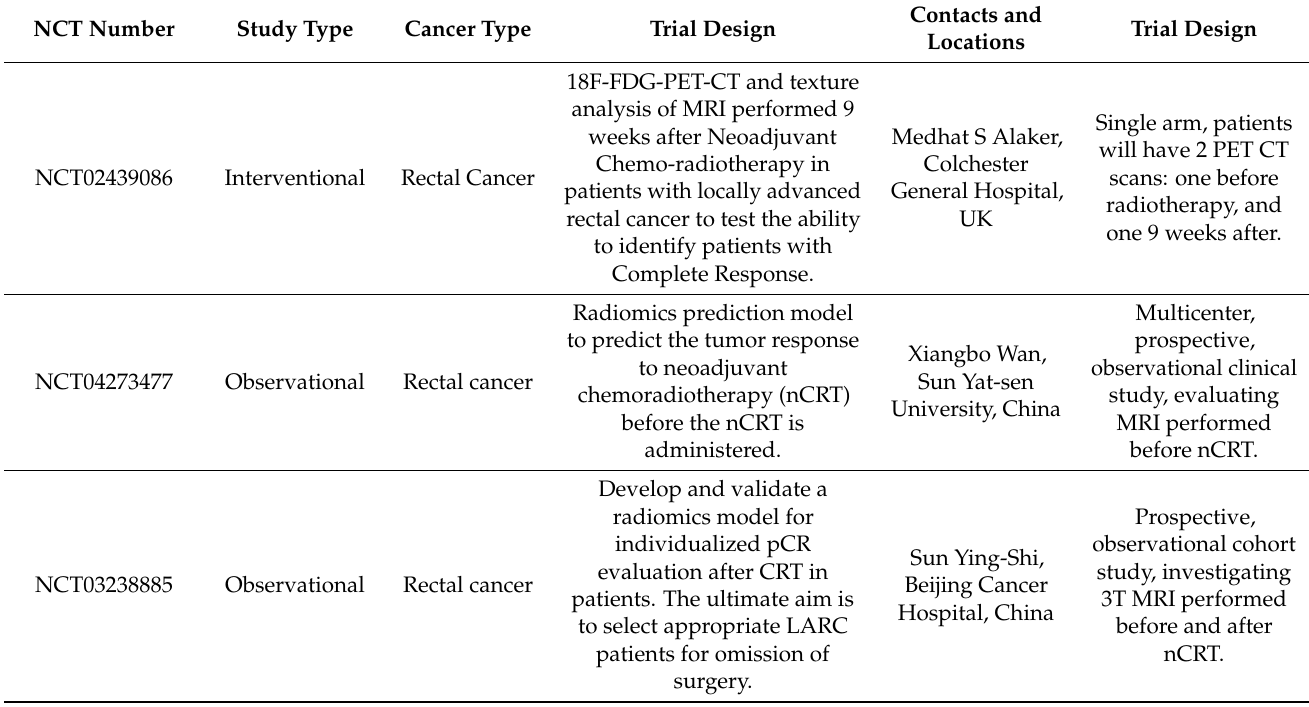
Table 1. Prospective clinical trials investigating the potential role of texture analysis in neoadjuvant radiotherapy. NCT